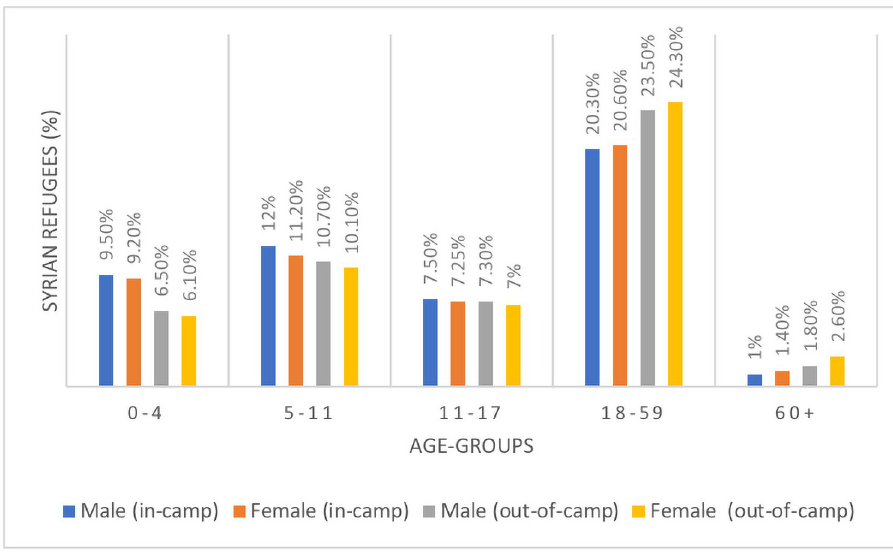
Fig 1. Percentage of Syrian refugees by age-groups and sex in Jordan by September 2020. Source: United Nations High Commissioner for Refugees (UNHCR).